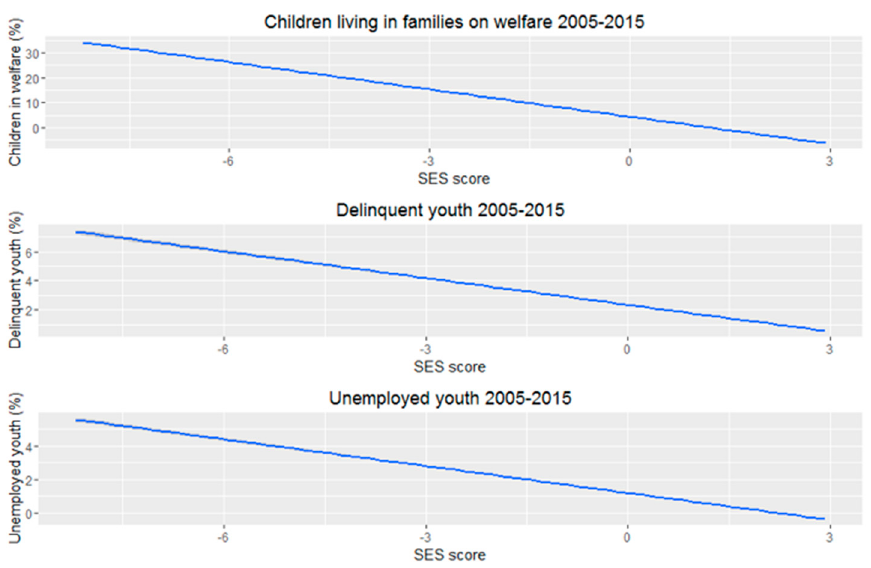
Figure 1. Trends of children living in families on welfare, delinquent youth and unemployed youth over time. (2005–2015). Table 2. Characteristics of social indicators of child wellbeing.